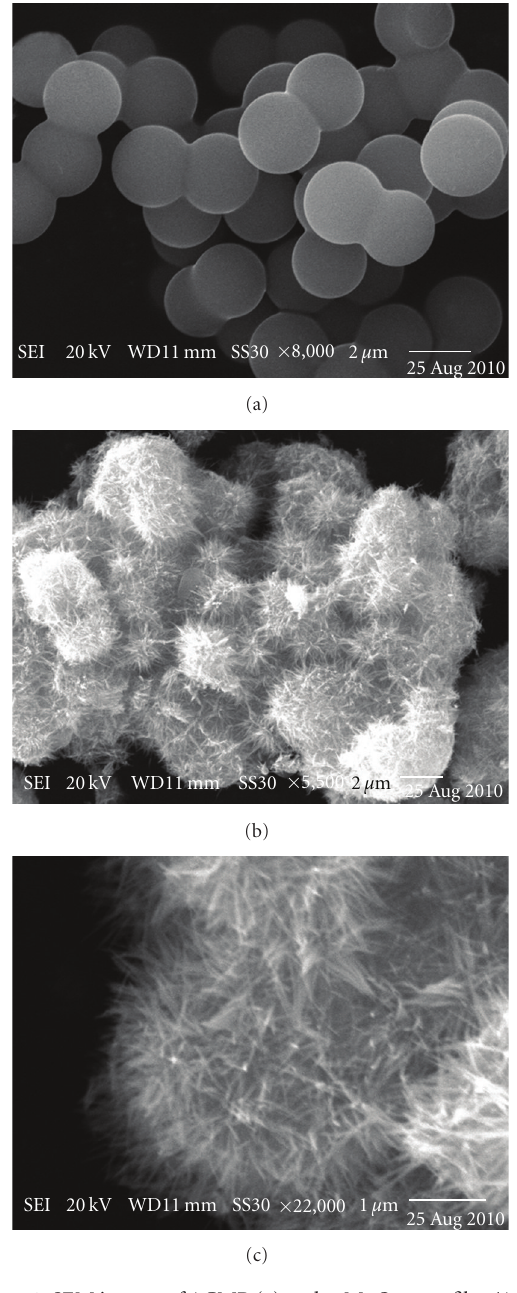
Figure 1: SEM images of ACMB (a) and γ -MnO 2 nanofibre/ACMB composite (b) low magnification, (c) high magnification.